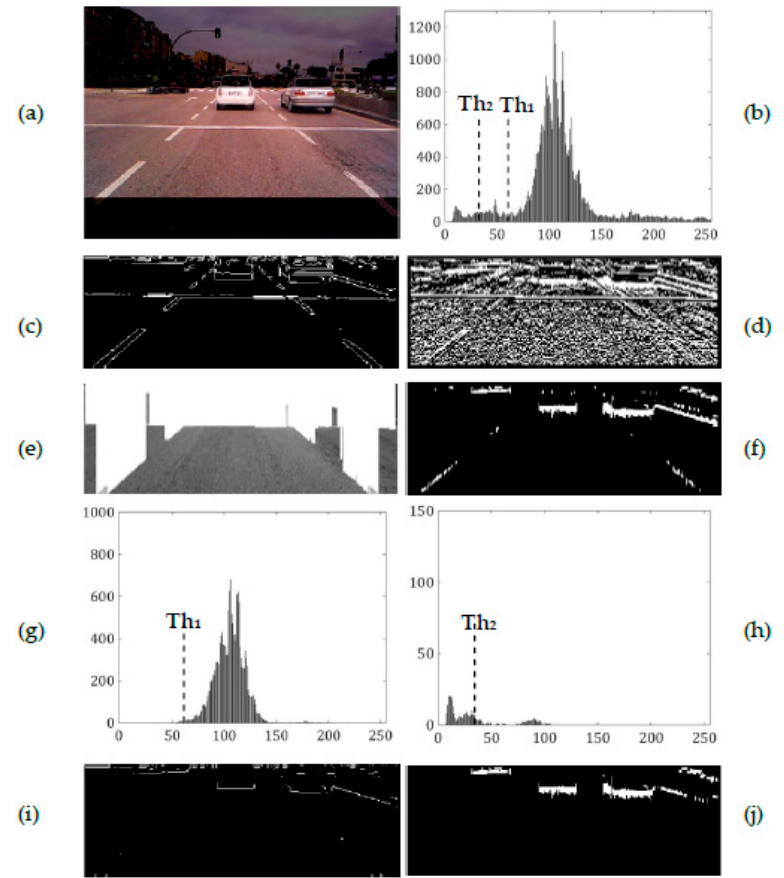
Figure 9. Road scene on cloudy day. ( a ) Searched image area, ( b ) its greyscale histogram. Left column (method proposed in [21]): ( c ) edge map, ( e ) free driving road, ( g ) histogram of the free driving road and ( i ) edge map after intensity thresholding. Righ column (our method): ( d ) vertical intensity gradients, ( f ) M ( x , y ) after application of saturation and intensity constraints, ( h ) histogram of set of upper pixels of the gradients and ( j ) M ( x , y ) after intensity thresholding.